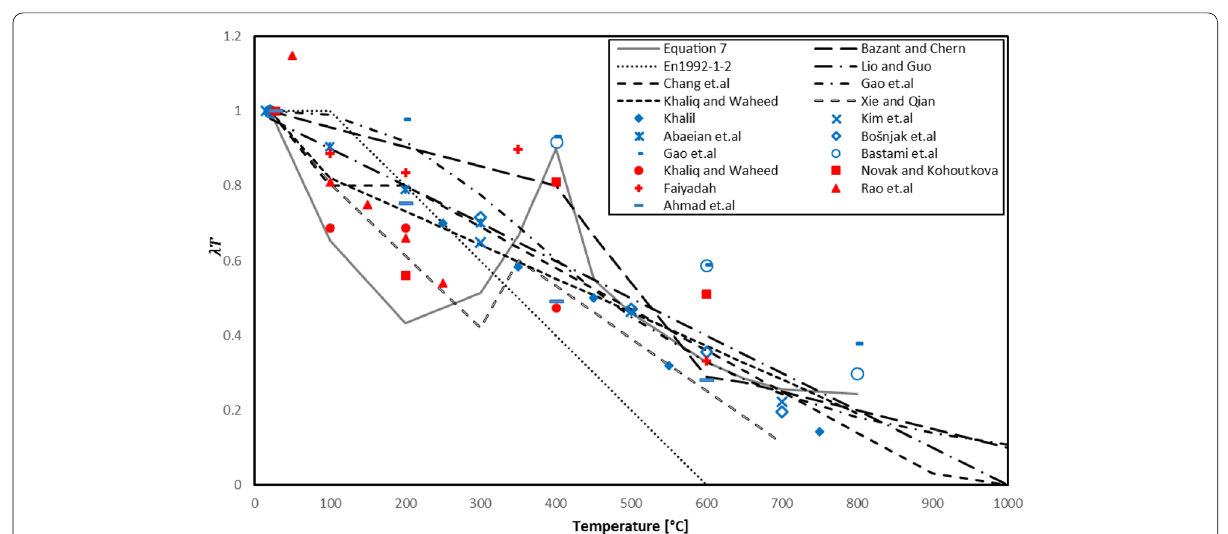
Fig. 8 Comparison between proposed (cid:31) T equation with previous equations and earlier experimental